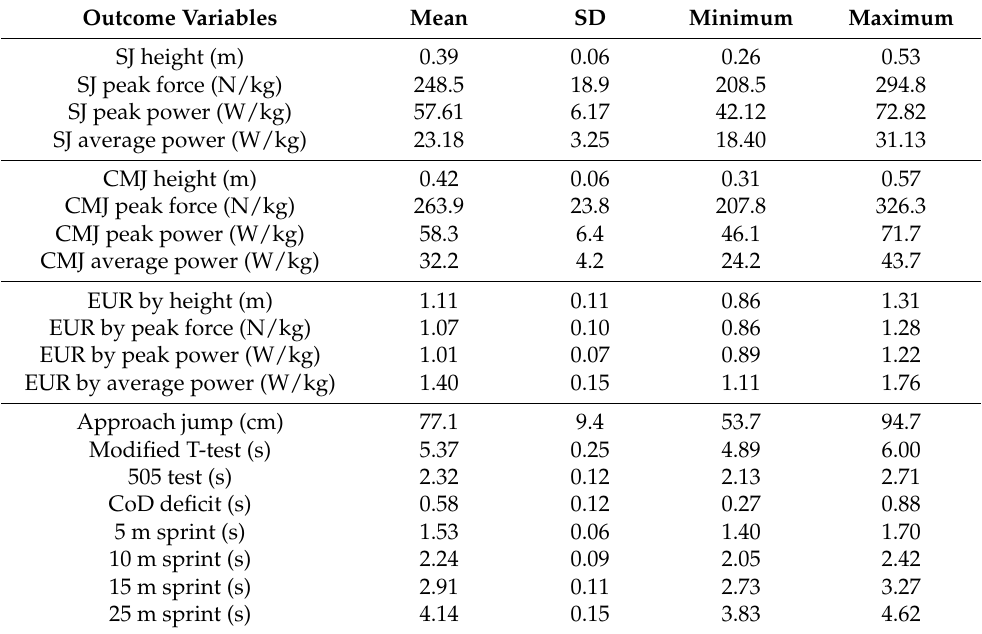
Table 1. Descriptive statistics for all outcome